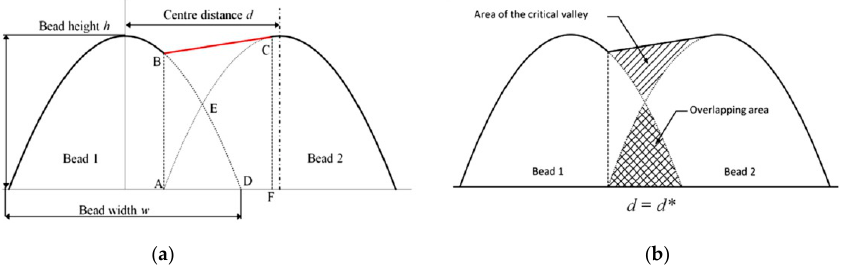
Figure 28. Tangent Overlapping Model: ( a ) two weld beads; ( b ) the overlapped profile. Reprinted from Ref.